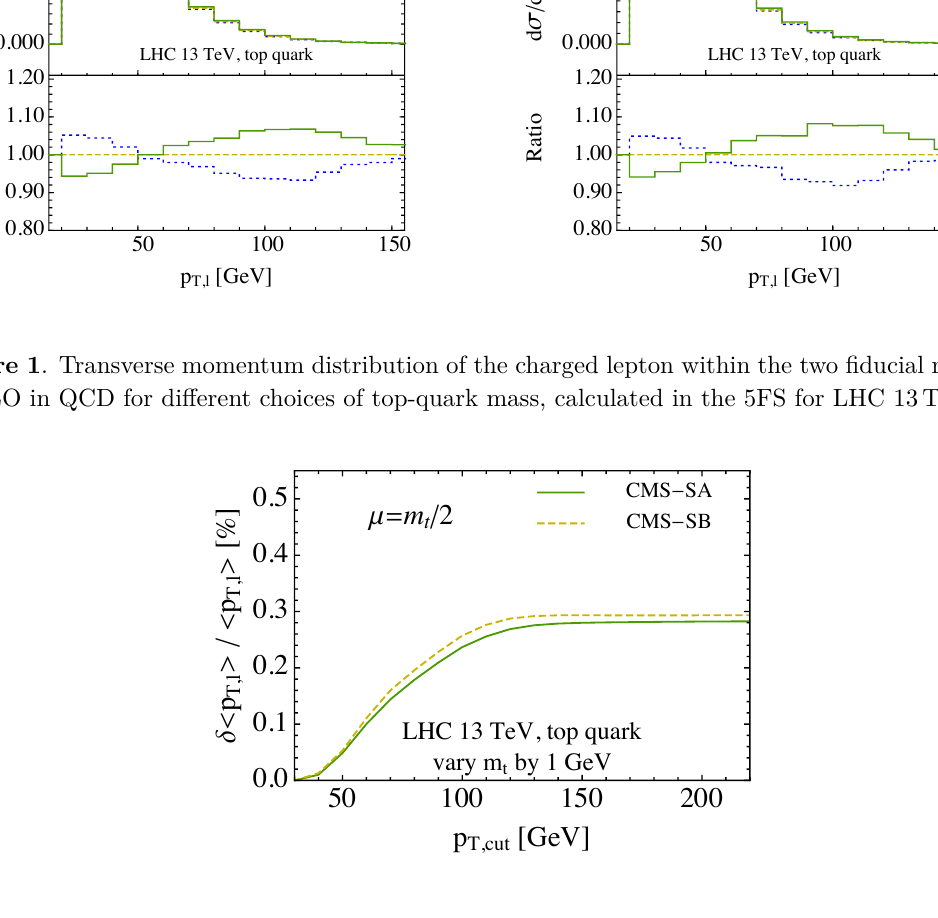
Figure 2 . Induced change of the average transverse momentum of the charged lepton within the two fiducial regions when varying the top-quark mass by 1 GeV, as a function of an upper limit on the transverse momentum, calculated at NLO in QCD in the 5FS for LHC 13